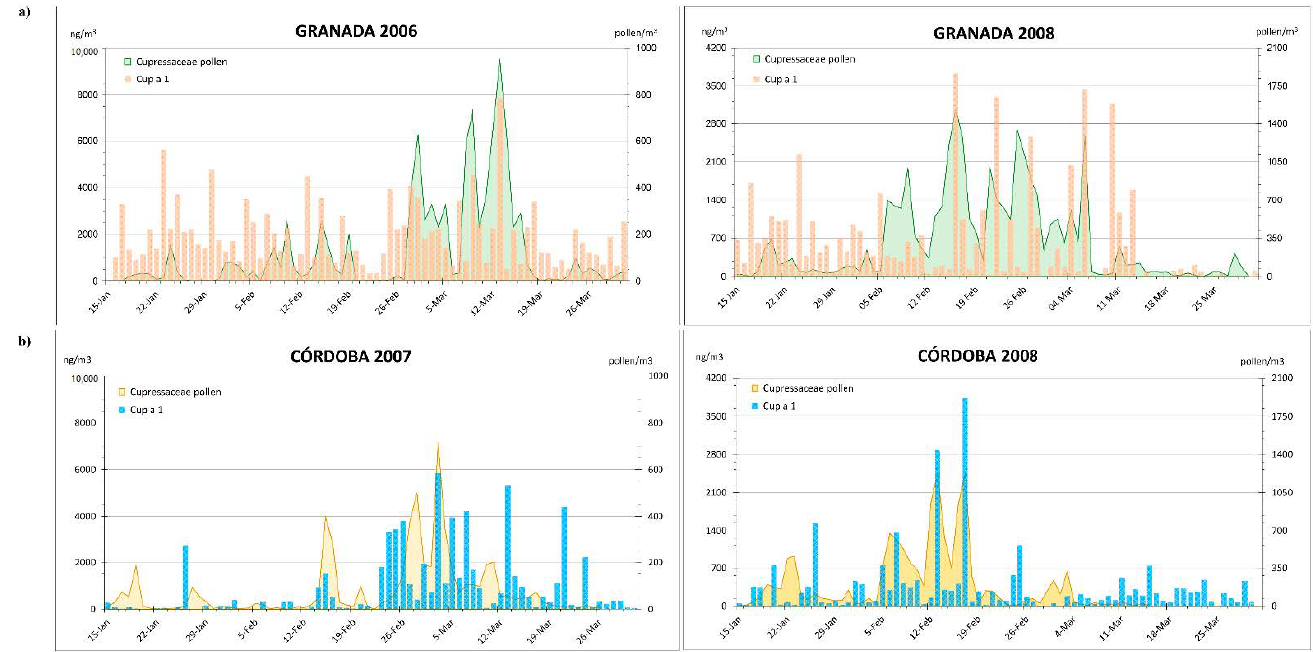
Figure 2. Dynamic of Cupressaceae pollen (pollen/m 3 ) and Cup a 1 (ng/m 3 ) distributed in PM10 and PM2.5 in Granada ( a ) and Córdoba ( b ). Table 2. Correlation coefficients for Cupressaceae pollen, Cup a 1 allergen, and allergens in PM10 and PM 2.5, ** p < 0.01; * p < 0.05. The shadow and bold format indicate the results more relevant. City Years Studied